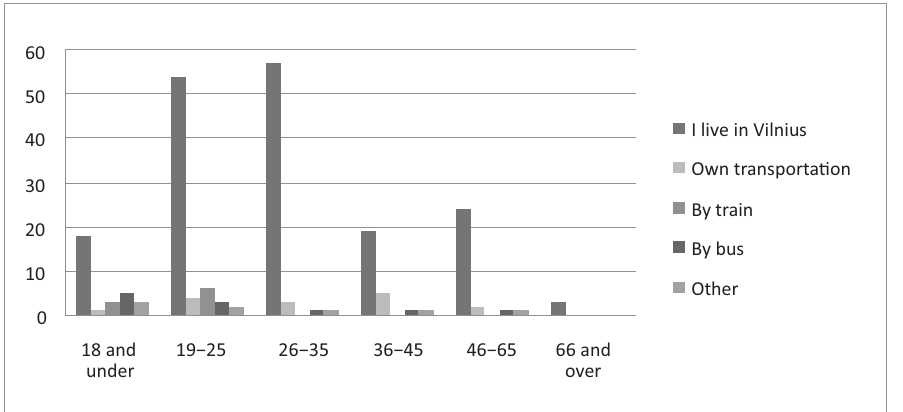
Fig. 12. Correlation between transportation type visitors have arrived to the festival and